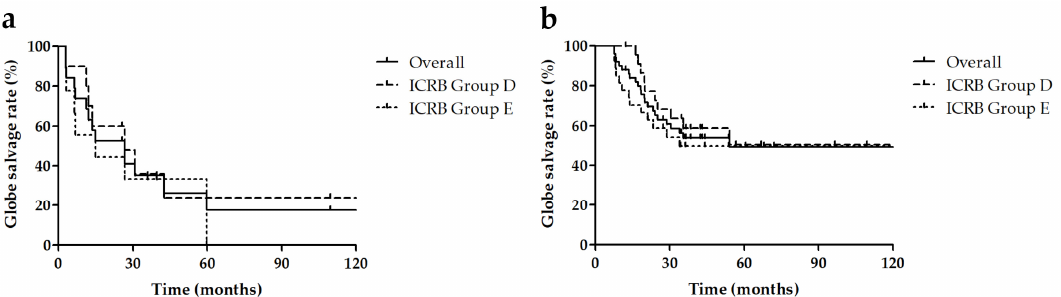
Figure 2. Kaplan–Meier curves showing globe salvage rates of advanced retinoblastoma treated with intravenous chemotherapy (IVC) alone ( a ) and with combined IVC and intraarterial chemotherapy (IAC) ( b ). ICRB: International Classification of Retinoblastoma; IVC: intravenous chemotherapy; IAC: intra-arterial chemotherapy.